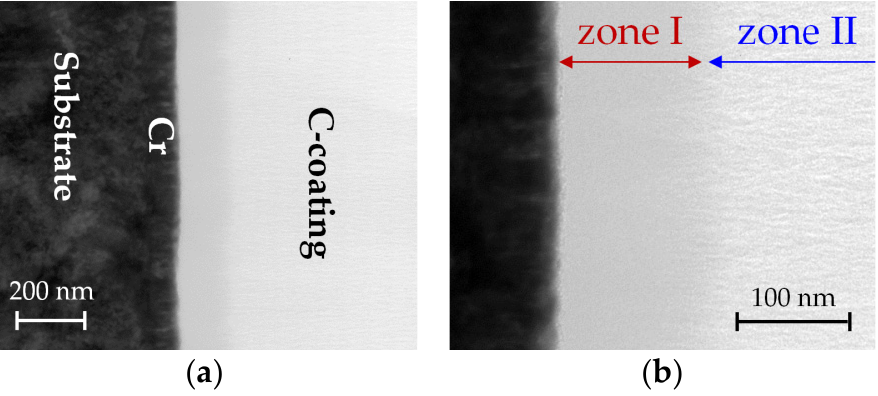
Figure 8. ( a ) TEM cross-section images of coating D. In particular, the higher magnification ( b ) shows a partition of the C-coating into a relatively structureless zone I and a nanostructured zone II for the main part of the coating.